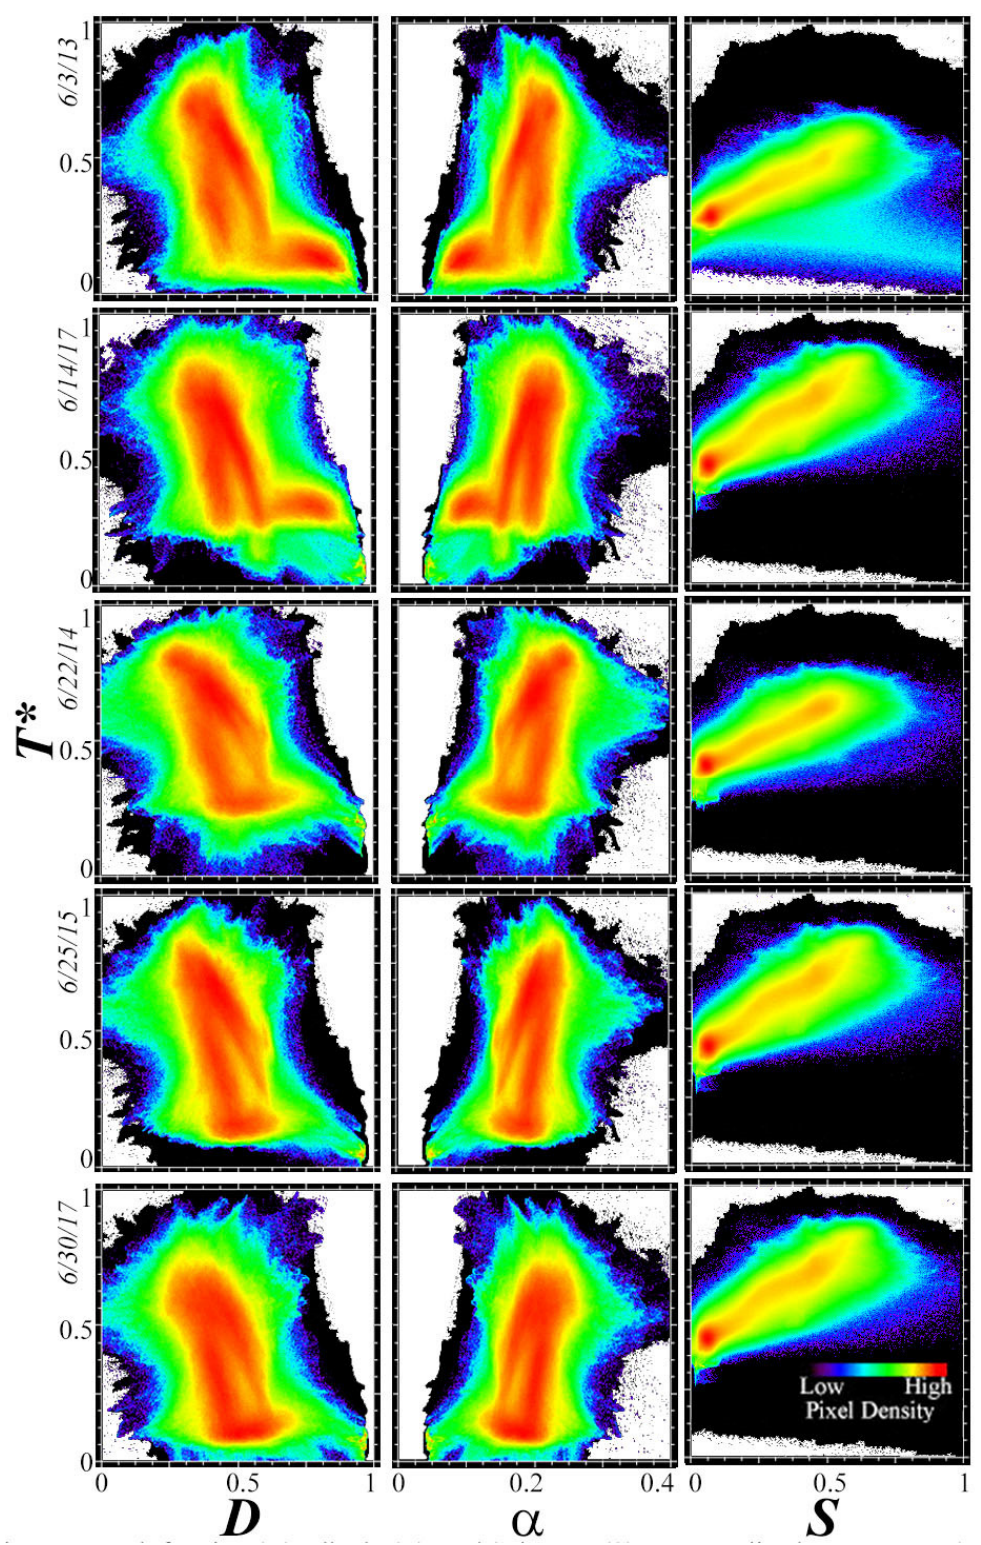
Figure 5. Dark fraction (D), albedo (α), and Substrate (S) vs normalized temperature (T*). The D vs T* relation is similar to the α vs T* relation (with a sign flip). In contrast, the S vs T relation is highly linear. Pixels which are cooler than the main S vs T relation are generally covered with NPV and pixels hotter generally correspond to low albedo soils.